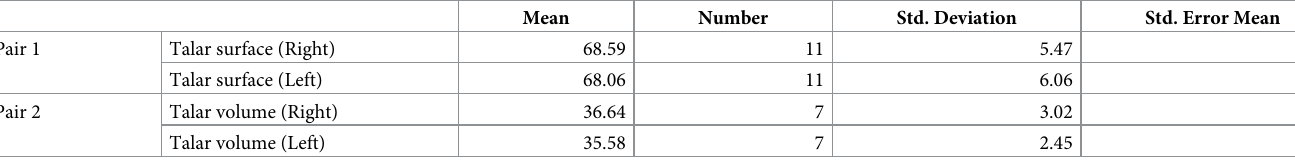
Table 3. The geometric profiles of talus from 11 matched pairs of tali.